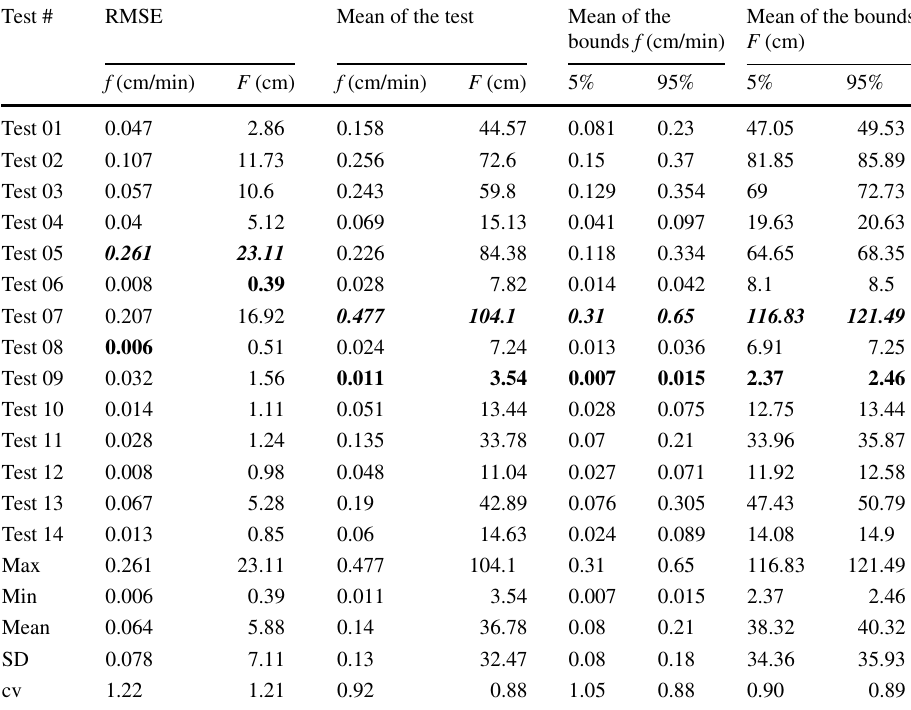
Max is the maximum, Min is the minimum, boldface numbers are minimum values, and bold italics are maximum